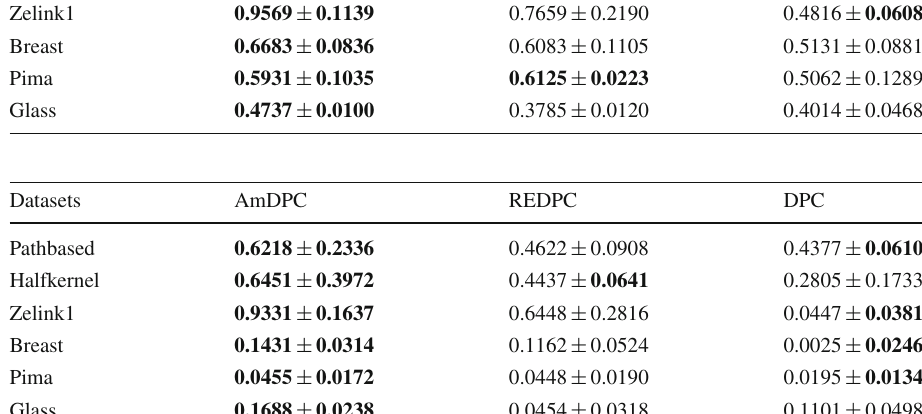
Table 8 Sensitivity analysis of ACC indicator when p ={1-8}